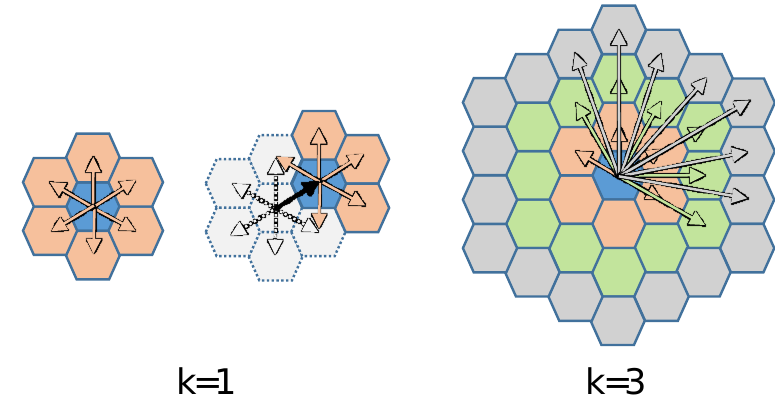
Figure 6. Hexagonal path search with k = 1 neighbor ring ( left ) and k = 3 neighbor rings ( right ).